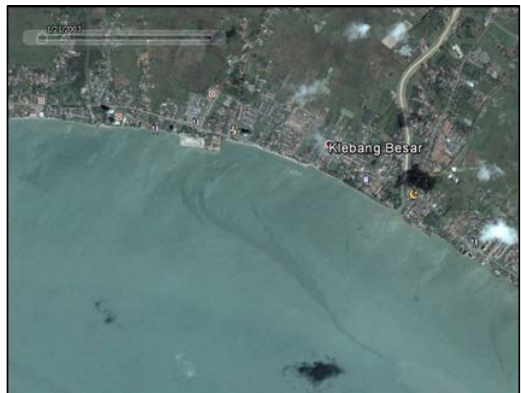
Figure 4. Banda Hilir in January 2003